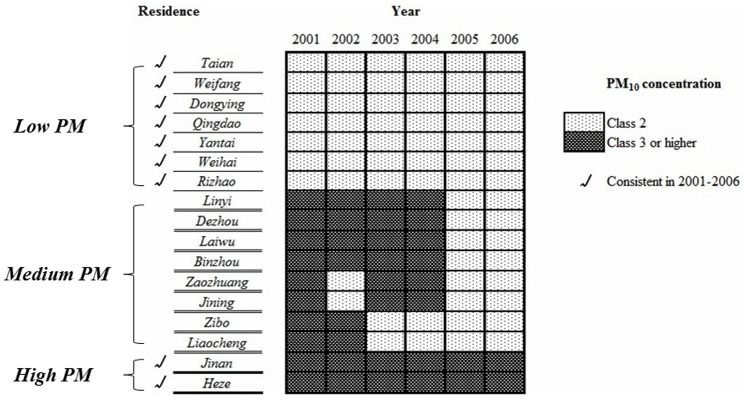
Exposure assessment and classification of participants according to residential levels of atmospheric particulate matter.Patients were classified into 3 groups according to the ambient PM10 class of their residence. Patients who resided in cities with Class 2 PM10 pollution were classified in the Low PM group, while the High PM group included cases with Class 3 or higher PM10 pollution. Patients living in areas with PM10 concentrations that varied between Class 2 and Class 3 were classified as the Medium PM group.